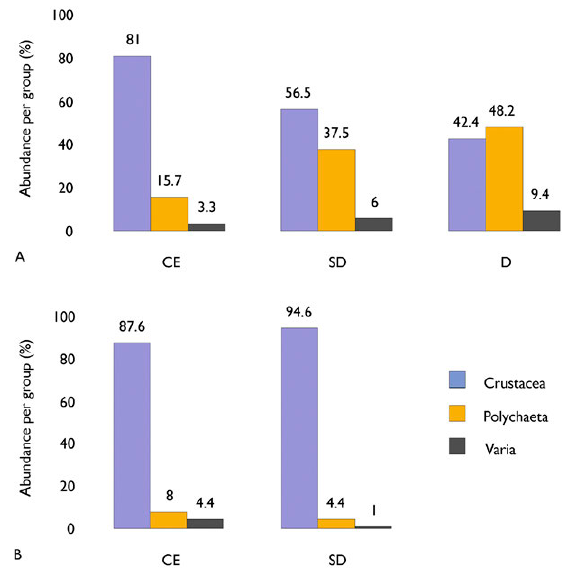
Fig. 6. – Abundance of symbionts per taxonomic group found in the examined specimens of Agelas oroides (A) and Aplysina aerophoba (B) across the surveyed caves (CE, entrance; SD, semidark zone; D, dark zone).